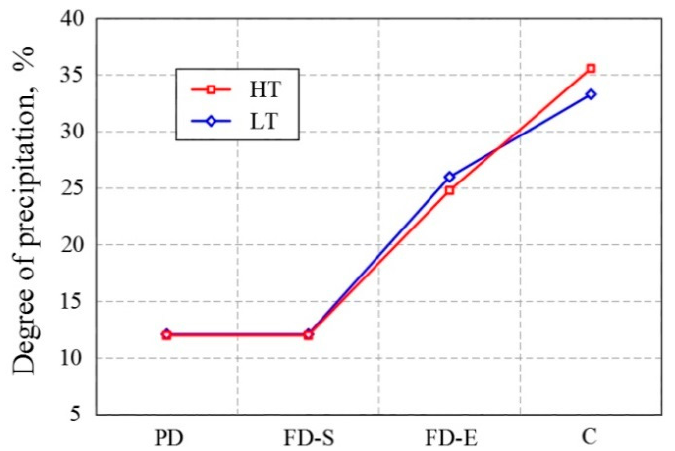
Figure 2. Degree of precipitation of niobium in each stage of thermomechanical processing. (PD: pre-deformation, FD-S: final deformation—start, FD-E: final deformation—end, C: cooling). Transmission electron analysis of the pre-deformed samples showed niobium precipitates (Figure 3). These precipitates were coarse, of spherical shape, and larger than 20 nanometers and were heterogeneously distributed in